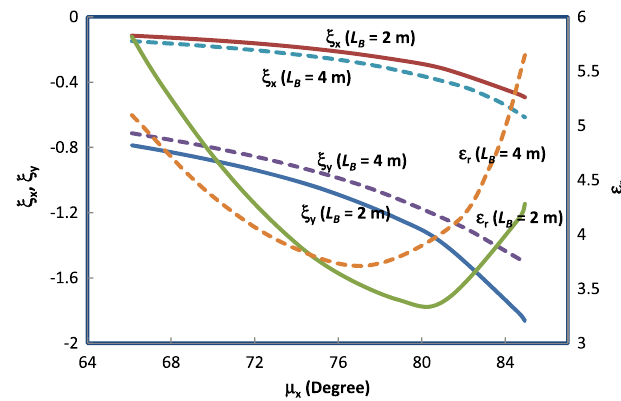
FIG. 6. ð A (cid:1) 2 : 5 Þ versus 1 =L B , A is the linear slope between the data of (cid:5) 2 r and ð D r (cid:1) 3 Þ of the simulations with different dipole length.